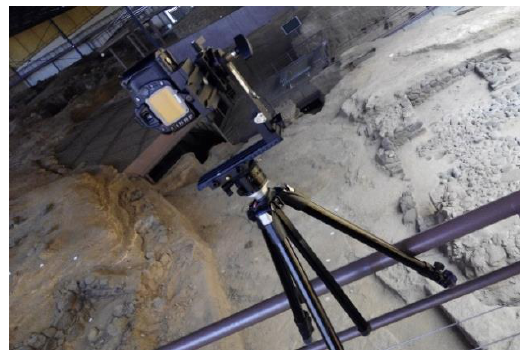
Figure 3. Image data acquisition with Nikon D80 for the generation of the virtual